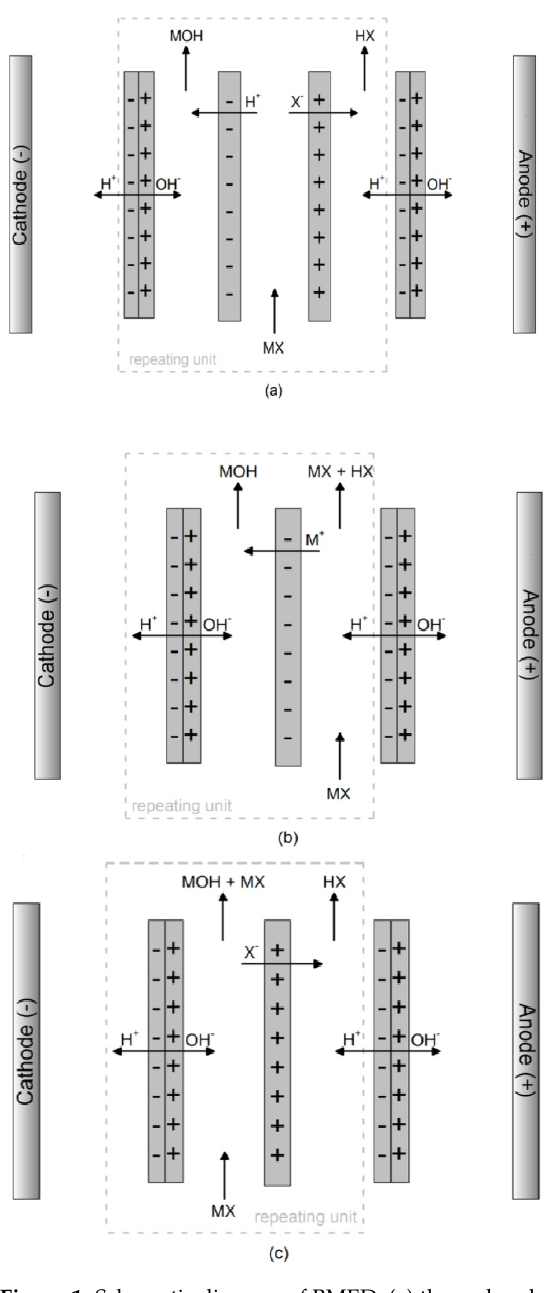
Figure 1. Schematic diagram of BMED: ( a ) three-chamber BMED; ( b ) two-chamber: base-BMED; and ( c ) two-chamber: acid-BMED [17].